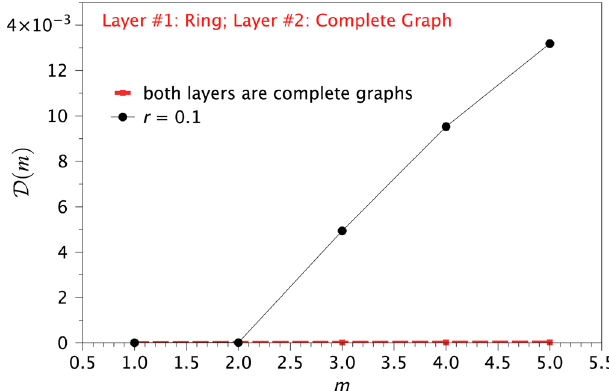
FIG. 10. Scenario 4. Normalized Kullback-Leibler divergence D ð m Þ between X ð t Þ and its Markovianized surrogate Y ð t Þ in the case where the second layer is a complete